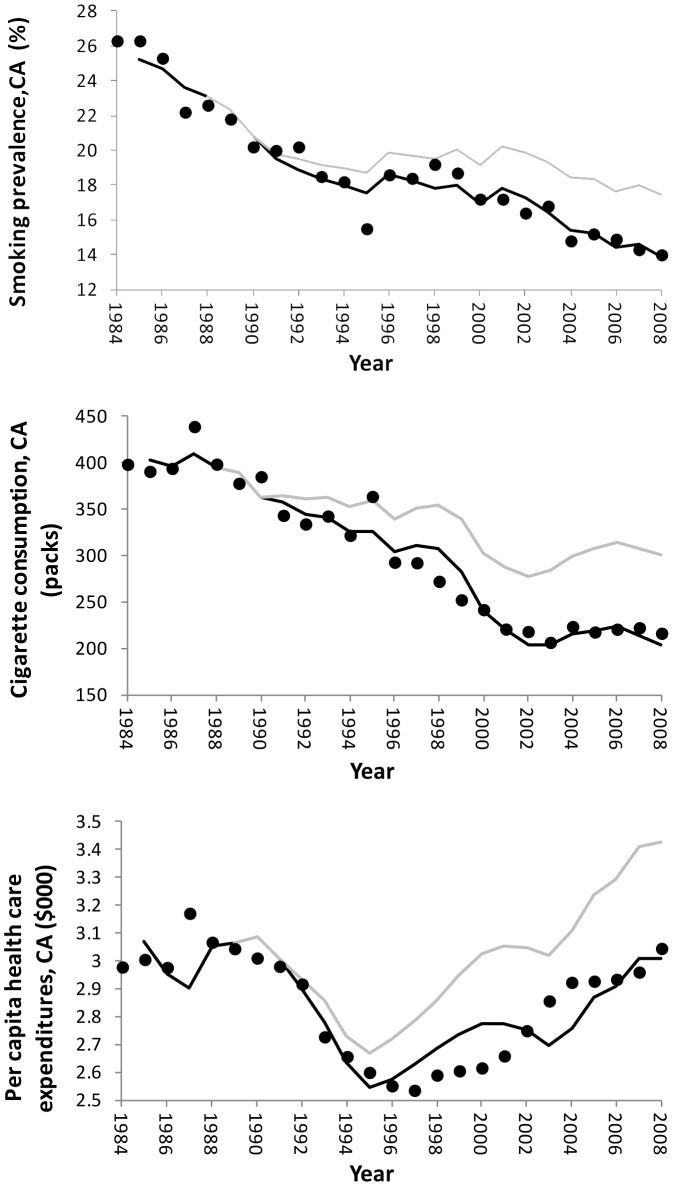
Prevalence of current smoking, cigarette consumption per smoker and per capita healthcare expenditures with and without California tobacco control funding, Top panel:California current smoking prevalence, middle panel: California cigarette consumption per smoker, bottom panel: California per capita healthcare expenditures using the NIPA measure. Black circles: observed, black line: predictions with California tobacco control program (using historical data on tobacco control funding), gray line: predictions without California tobacco control program (California tobacco control funding set to zero).